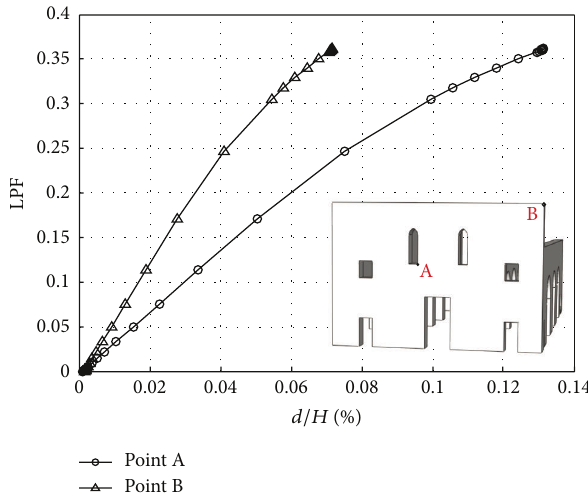
Figure 16: Mechanism 3: nonlinear FE analysis for the out-of-plane collapse of the fac¸ade considering the contribution of lateral and nave walls. Points A and B correspond with the location, where maximum and minimum displacements are measured, respectively.